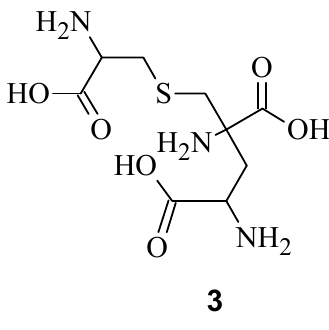
Figure 2. Chemical structure of labionin ( 3 ).